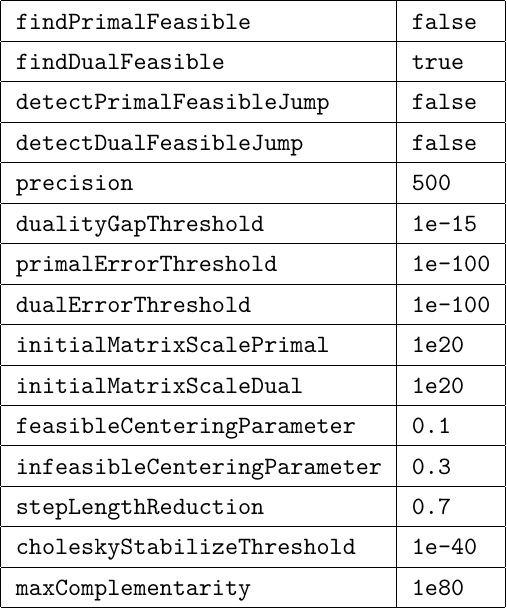
Table 2 . SDPB runtime